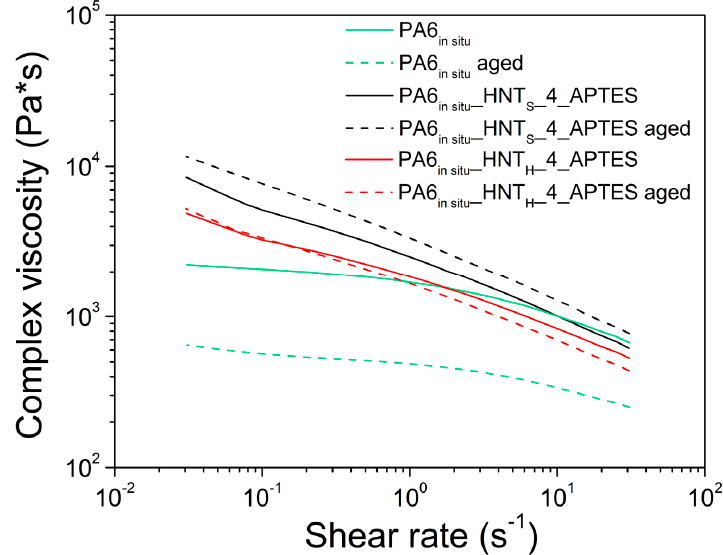
Figure 6. Rheological behavior of neat and APTES-functionalized HNT composites from in situ polymerization before and after hydrothermal ageing test.